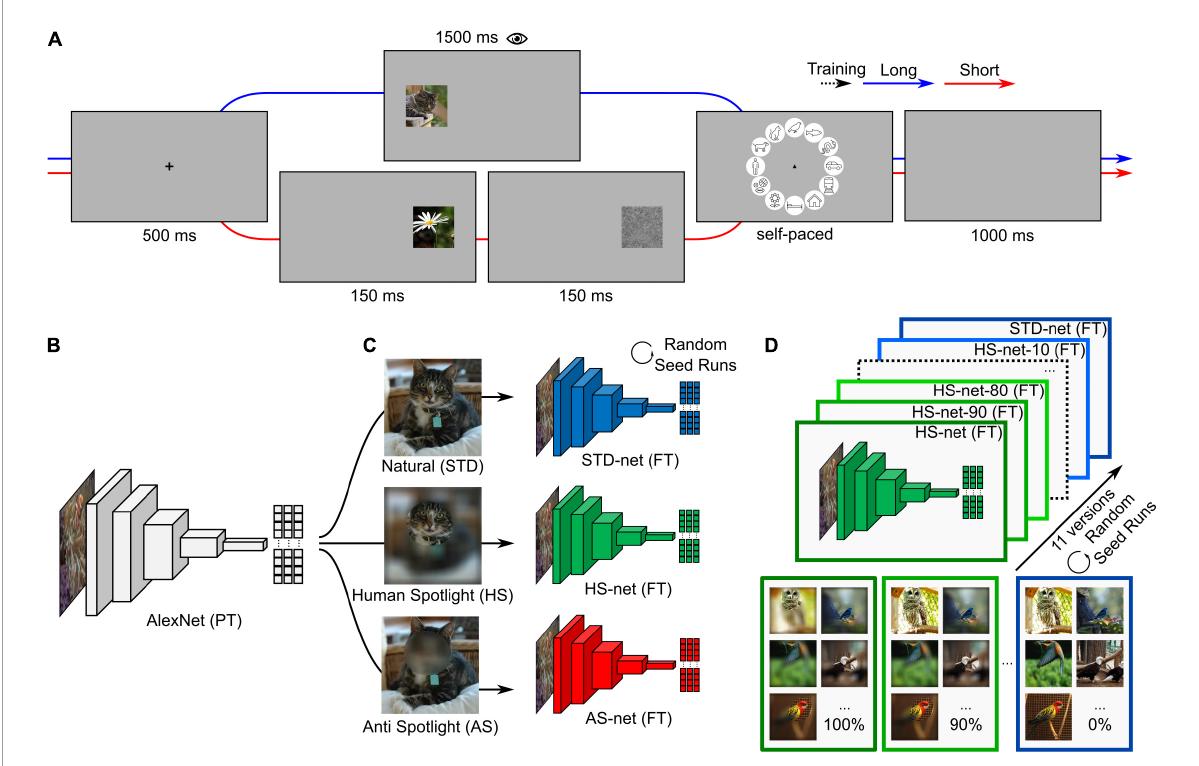
FIGURE1 Conceptual overview. (A) Experimental design of the eye tracking paradigm. The experiment consists of two blocks. Trials in the first block consist of a fixation cross (500 ms), followed by an image presented on either the left or the right side for a long duration (1,500 ms), a circular categorization screen with category icons (self-paced with a time limit of 5,000 ms), and a blank interstimulus interval (1,000 ms). Trials in the second block are similar except that an image was presented only briefly (150 ms) and followed by a visual backward mask (1/f pink noise; 150 ms). (B) Pretrained AlexNet (PT) consists of an image input, five convolutional, and three fully connected layers. (C) AlexNet versions are fine-tuned (FT) on identical images of twelve categories with different data-driven blurring manipulations (STD-nets, standard; HS-nets, Human-Spotlight; AS-nets, Anti-Spotlight). (D) HS-nets and AS-nets with different manipulation ratios in the training dataset are fine-tuned ranging from all HS and AS images (100%) to all STD images (0%) in steps of 10%. The same procedure, here visualized for HS-nets, was applied to AS-nets with the corresponding manipulation type. Source: images of cat, birds, and nature obtained from the Ecoset image dataset